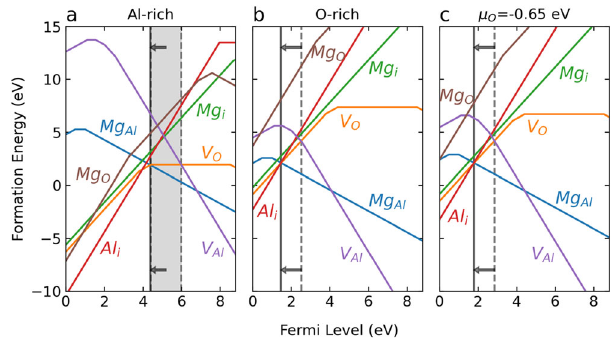
Fig. 2 Density functional theory simulation of MgO doping effect. The defect formation energy as function of the Fermi level for native and Mg- related defects in Al 2 O 3 for chemical potentials corresponding to a Al-rich, b O-rich, and c an oxygen chemical potential ( µ 0 ) of − 0.65 eV (to mimic atomic layer deposition growth